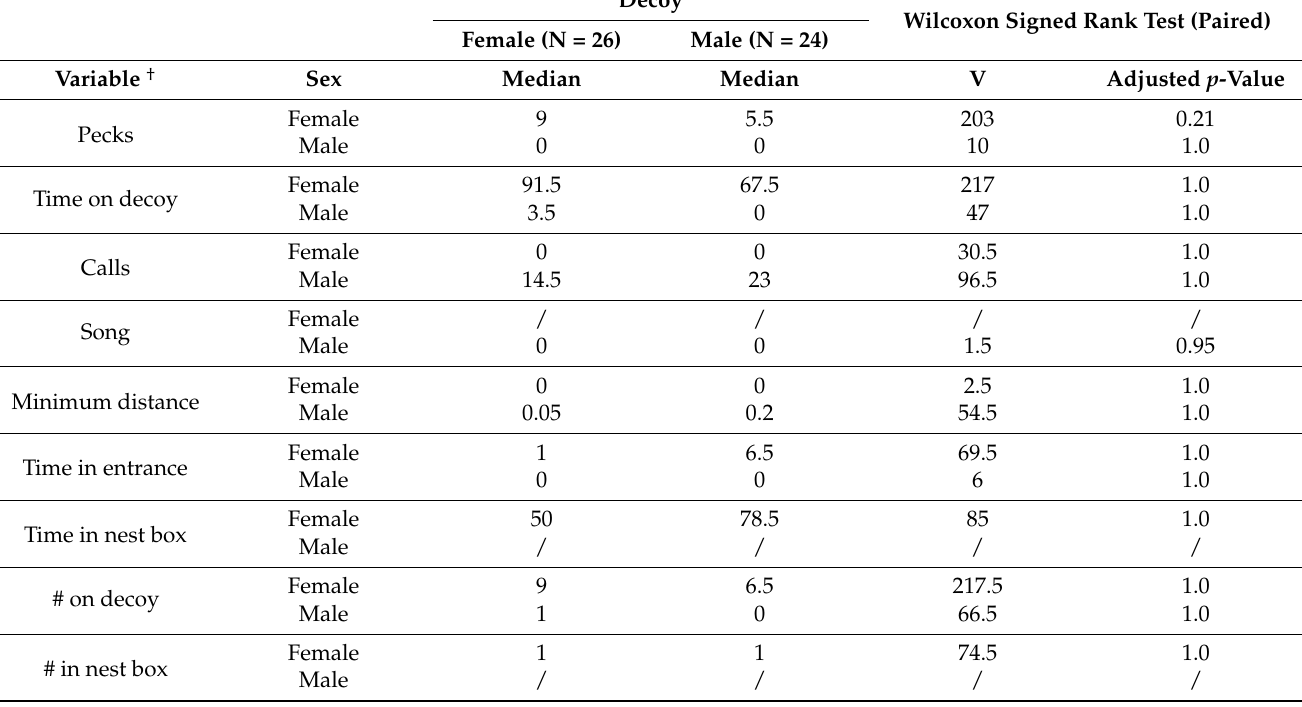
Table A2. Results of Wilcoxon signed rank tests comparing aggression variables for both sexes (N Female = 26; N Male = 24) between the trials on female and male decoys. The median, test statistic and adjusted p -values with the Holm correction for multiple testing are presented